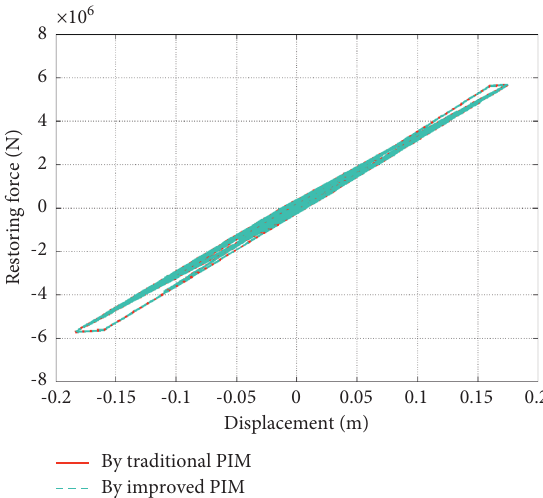
Figure 8: Restoring force-displacement curve of main pier under rare earthquake